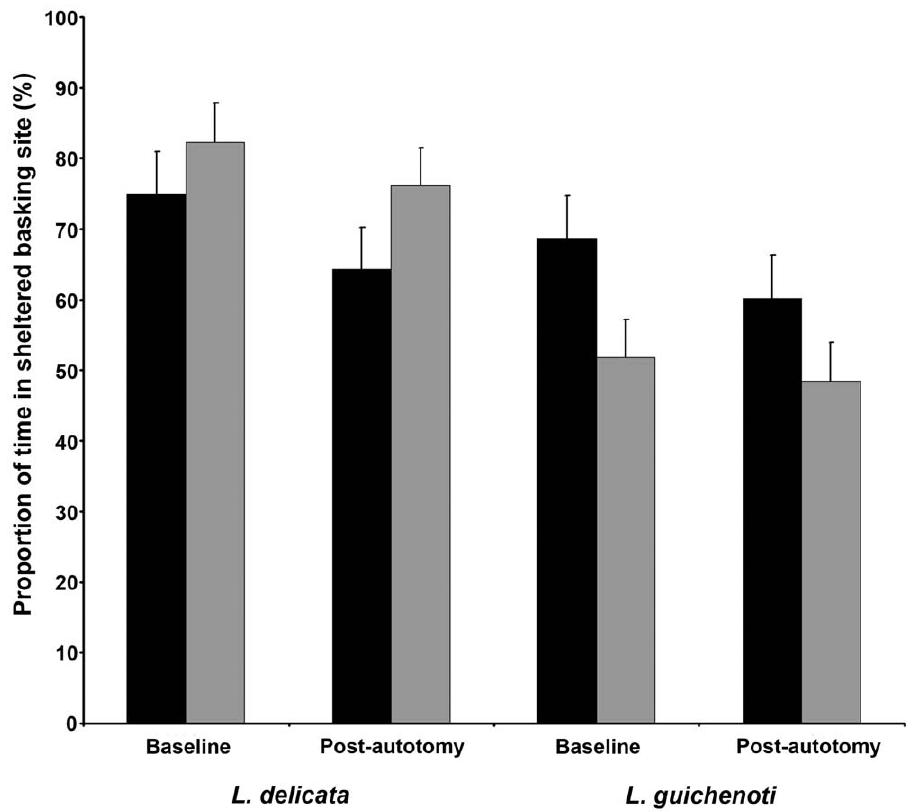
Figure 4. Proportion of time spent in the sheltered basking site by Lampropholisdelicata and L.guichenoti prior to the experimental treatment (baseline trial), and following the inducement of caudal autotomy in the experimental group (post-autotomy trial). The control (black bars) and experimental groups (grey bars) within each species are indicated. Error bars indicate 6 1 SE.